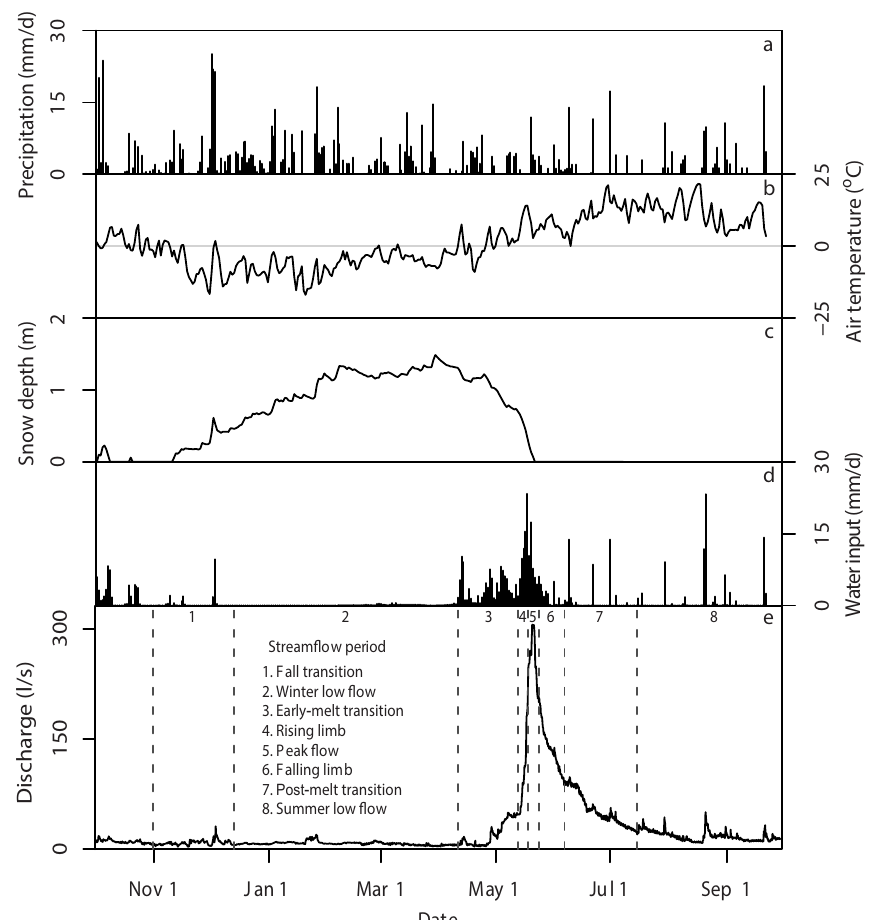
Figure 2. Precipitation and snow depth at the UC climate station throughout the period of record, air temperature and water input as means among all six lysimeter sites in the UEC catchment, and streamflow at the UEC catchment outlet with corresponding streamflow periods. The annual streamflow period is the aggregation of periods 1 through 8. The spring melt streamflow period is the aggregation of periods 3 through